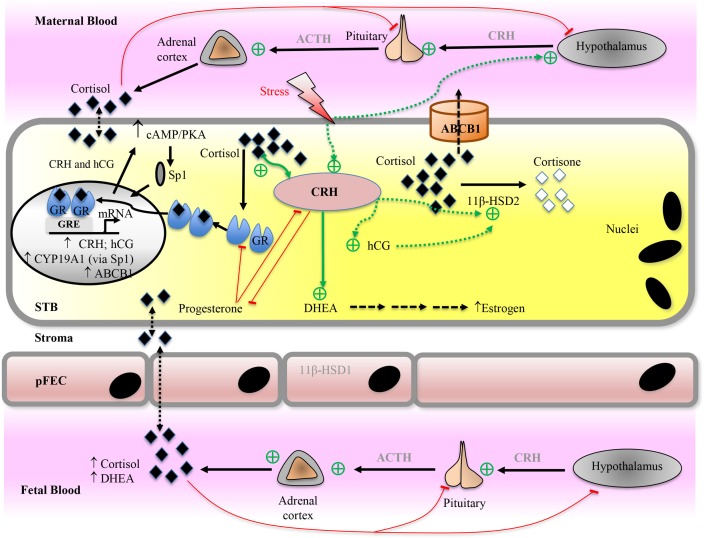
Proposed model for placental glucocorticoid (cortisol) function and metabolism. For detailed description, see text. Cortisol can diffuse across cell membranes and regulate target protein expression directly via glucocorticoid receptor (GR) or indirectly via other transcription factors (e.g., Sp1). Placental corticotropin-releasing hormone (CRH) is the major mediator of adaptive response to stressors during pregnancy. Cortisol stimulates placental CRH expression, which regulates placental hormone levels (e.g., hCG, estrogen, progesterone, and 11β-HSD2). Red arrows indicate inhibiting/negative feedback pathways, while green arrows indicate stimulating pathways. ABC transporters, ATP-binding cassette transporters; ACTH, adrenocorticotropic hormone; CRH, corticotropin-releasing hormone; DHEA, dehydroepiandrosterone; GRE, glucocorticoid response element; HSD, hydroxysteroid dehydrogenase; hCG, human chorionic gonadotropin; pFEC, placental-fetal endothelial cell; PKA, protein kinase A; Sp1, specificity protein 1 transcription factor; STB, syncytiotrophoblast.